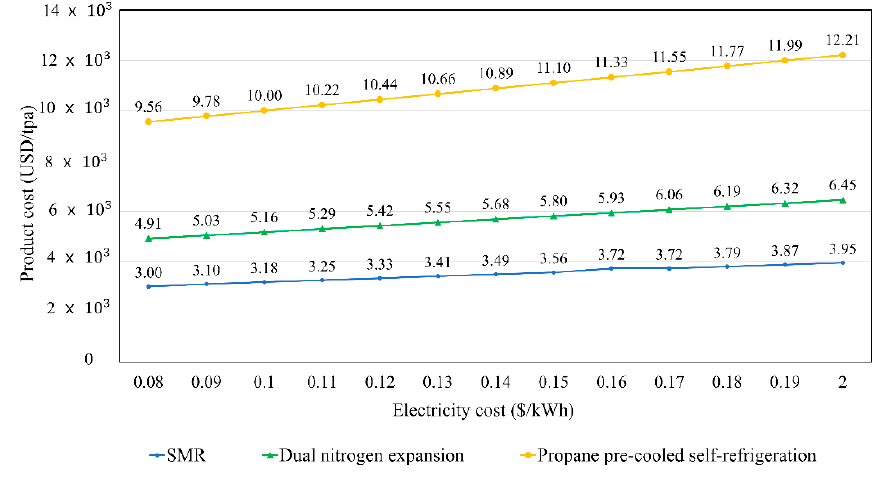
Figure 15. E ff ects of electricity cost on product cost of each Figure 15. Effects of electricity cost on product cost of each process.